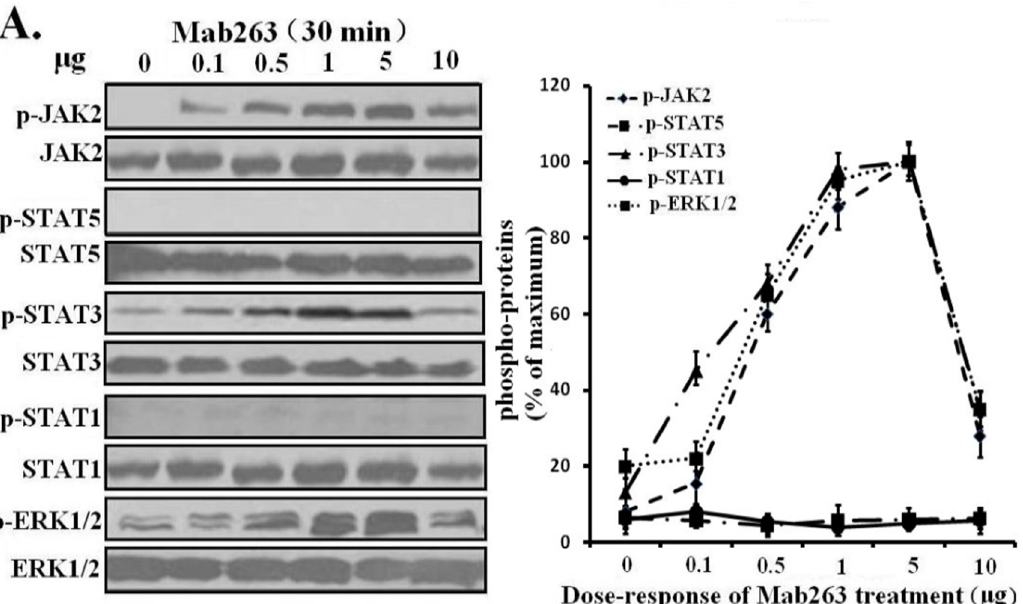
Figure 4. Dose-response and time-course profiles for intracellular signaling proteins activated by Mab263 in the mouse GHR cell model. ( A ) Dose response for tyrosine phosphorylation of JAK2, STAT1/3/5 and ERK1/2 induced by Mab263 in 3T3-F442A cells. The cells were cultured in serum-free medium overnight and incubated with increasing concentrations of Mab263 (0 to 10 μ g/mL) for 30 min at 37 °C. After discarding these liquids, the cell layer was quickly washed three times with ice-cold PBS. The cells were then lysed and collected as described in the Materials and Methods. The samples were then subjected to SDS-PAGE, transferred to PVDF membranes, and western blot analysis was performed with the indicated antibodies. ( Right ) The corresponding histograms of the data of three separate western blot analyses. Densitometry data for p-JAK2, p-STAT1/3/5 and p-ERK1/2 were normalized to that of total JAK2, total STAT1/3/5 and total ERK1/2. For each signal protein (p-JAK2, p-STAT1/3/5 and p-ERK1/2), the maximum signal achieved in response to Mab263 was considered 100%. The data shown are the mean ± SE ; and ( B ) Time course for tyrosine phosphorylation of JAK2, STAT1/3/5 and ERK1/2 induced by Mab263 in 3T3-F442A cells. The cells were cultured in serum-free medium overnight and incubated with 5 μ g of GH for different times (0–60 min) at 37 °C. After removing these liquids, the cell layer was quickly washed three times with ice-cold PBS. The cells were then lysed and collected as described in the Materials and Methods. The samples were then subjected to SDS-PAGE, transferred to PVDF membranes, and western blot analysis was performed with the indicated antibodies. Detection was performed using the ECL detection system. After detection, the membranes were stripped and re-probed with antibodies to the total JAK2, STAT1/3/5 and ERK to verify equal protein loading in each lane. ( Right ) The corresponding histograms of the data of three separate western blot analyses. Densitometry data for p-JAK2, p-STAT1/3/5 and p-ERK1/2 were normalized to that of total JAK2, total STAT1/3/5 and total ERK1/2. For each signal protein (p-JAK2, p-STAT1/3/5 and p-ERK1/2), the maximal signal achieved in response to Mab263 was considered 100%. The data showed are the mean ± SE; p,